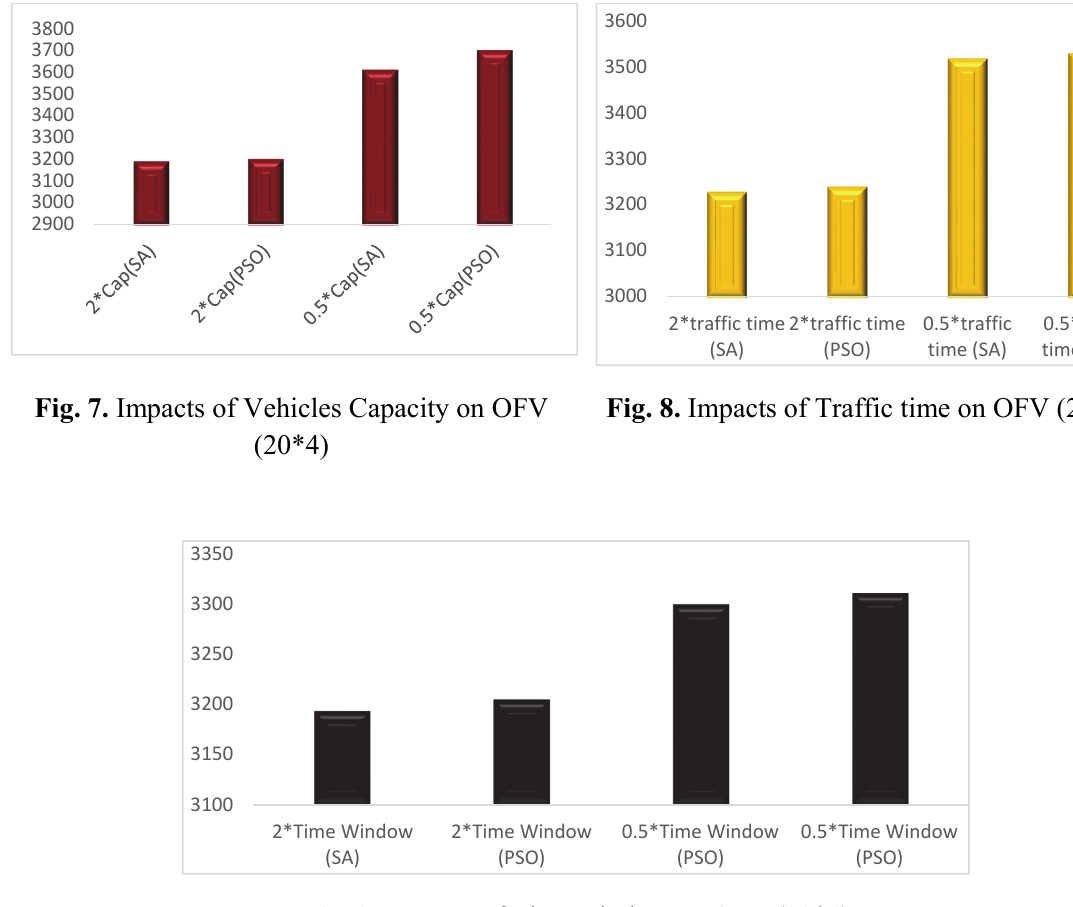
Fig. 9. Impacts of Time window on OFV